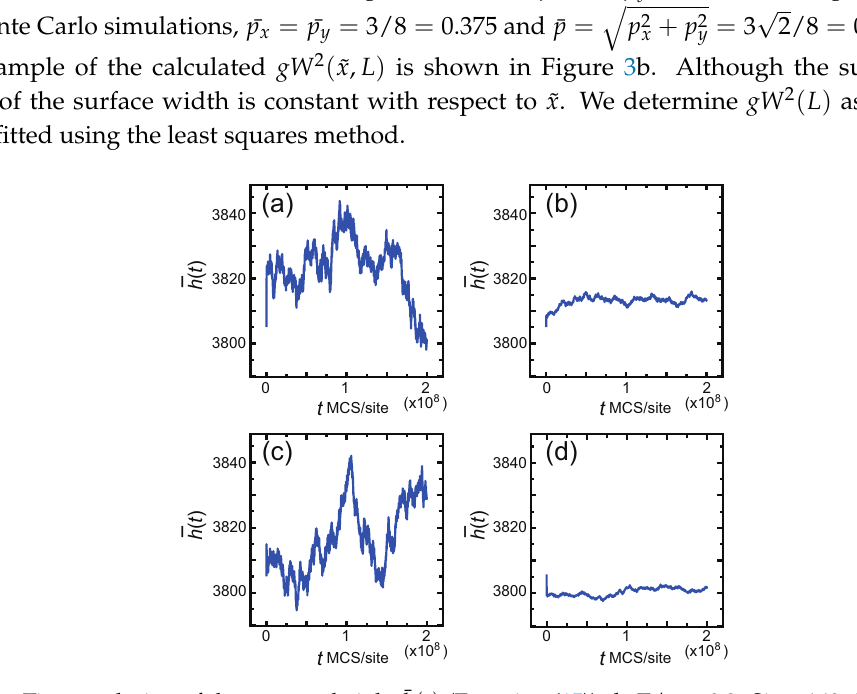
Figure 4. Time evolution of the average height ¯ h ( t ) (Equation (15)). k B T / (cid:101) = 0.2. Size: 160 N step =120. ∆ µ A / (cid:101) = ( a ) 0.0, ( b ) 2.0, ( c ) 4.0, and ( d )